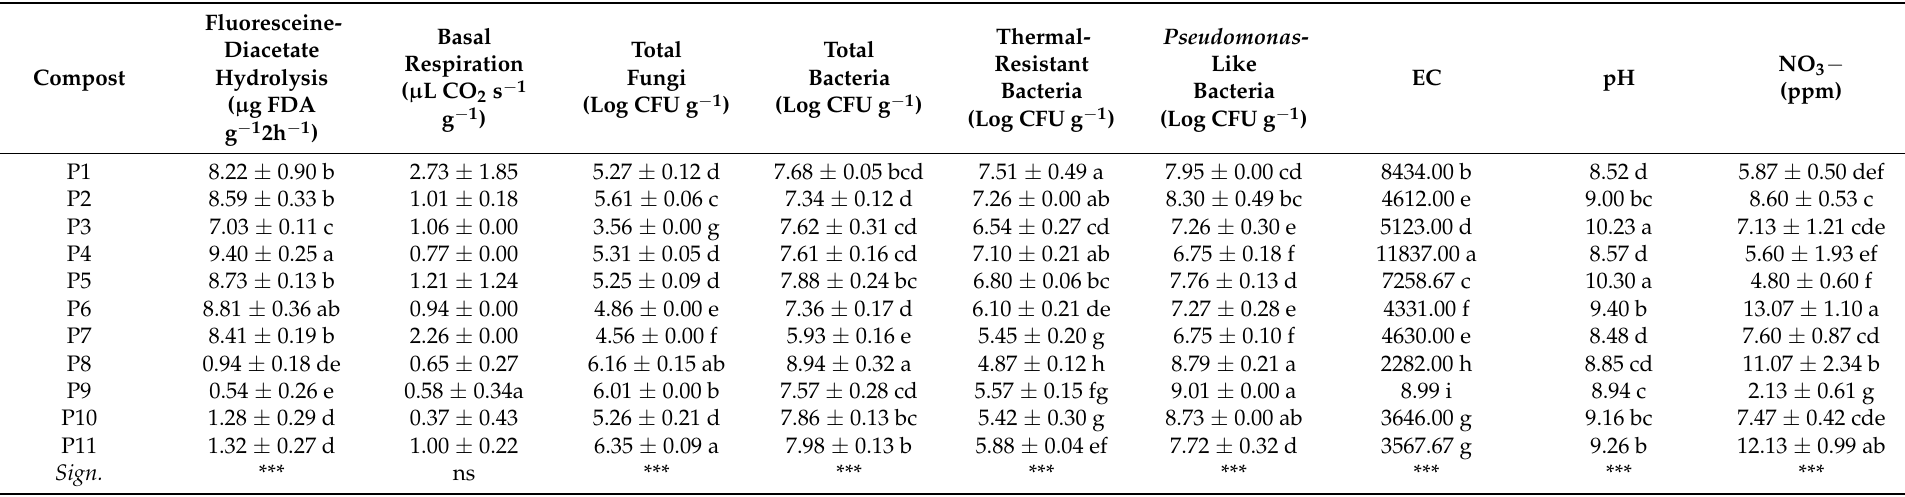
Table 3. Some biological, microbiological, physico-chemical and chemical properties of the composts (P1–P11). Asterisks indicate that the differences indicated by lowercase lettering are statistically significant ( p < 0.001). Non-significance is reported as